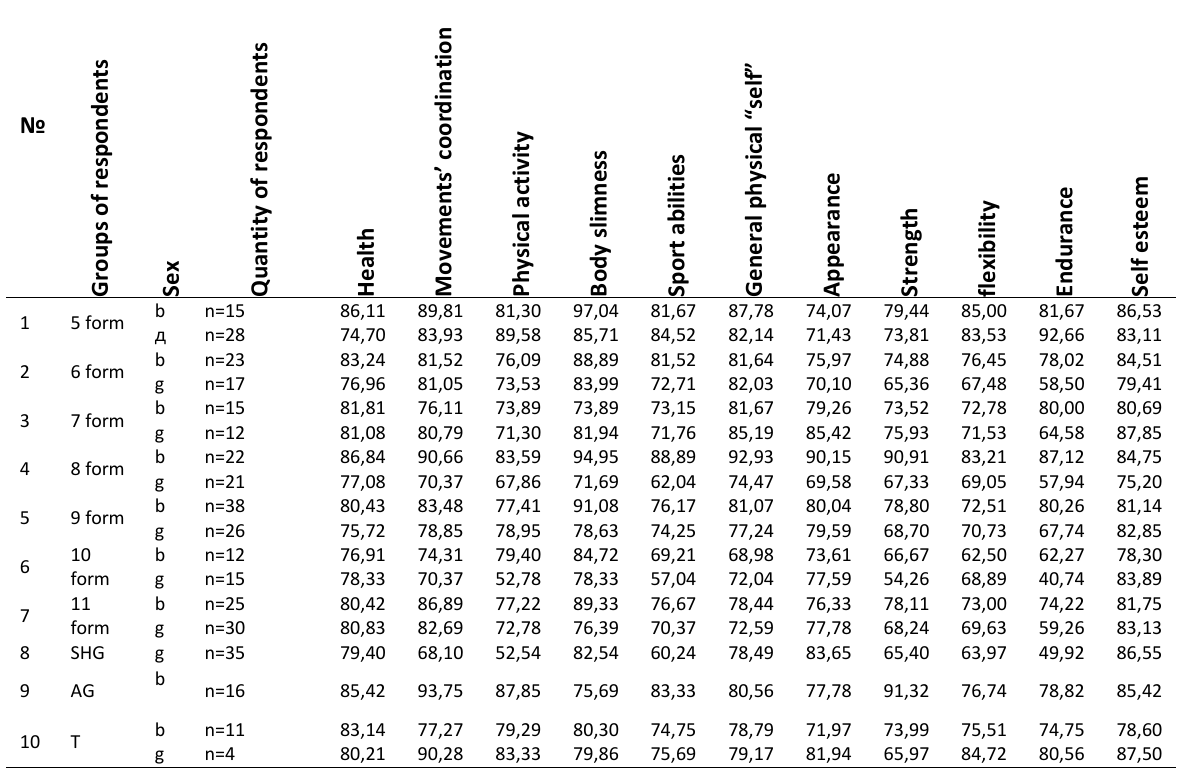
Table 1. Mean values of indicators of questionnaire “Self description of physical condition” (% from maximal quantity of